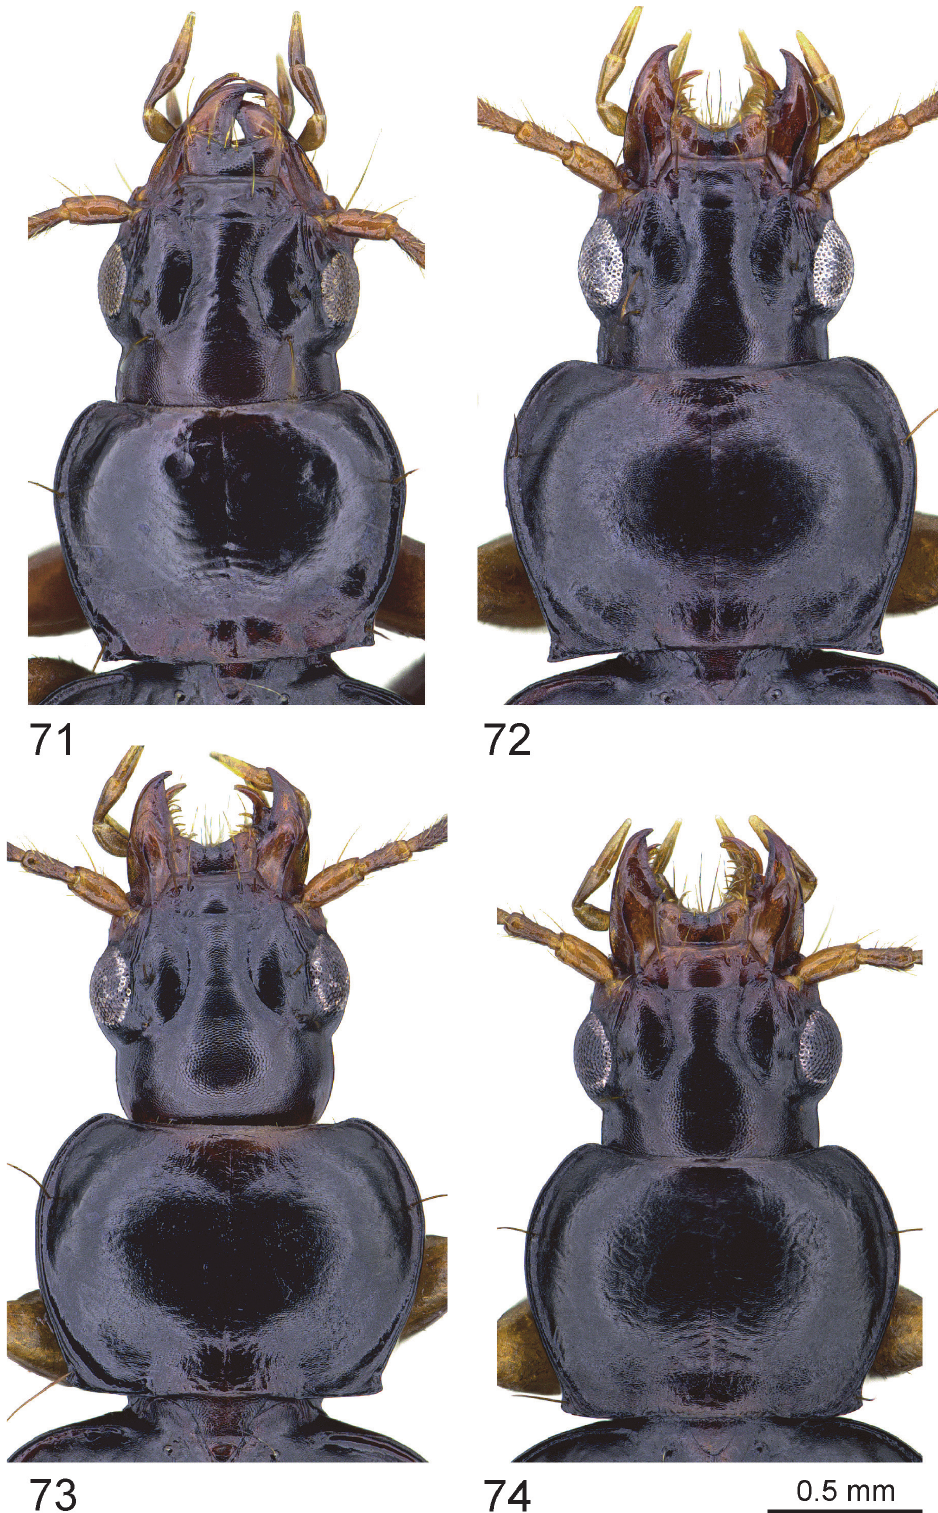
Figs 71–74. Trechus spp., head, pronotum. 71 . T. depressipennis sp. nov., holotype. 72 . T.